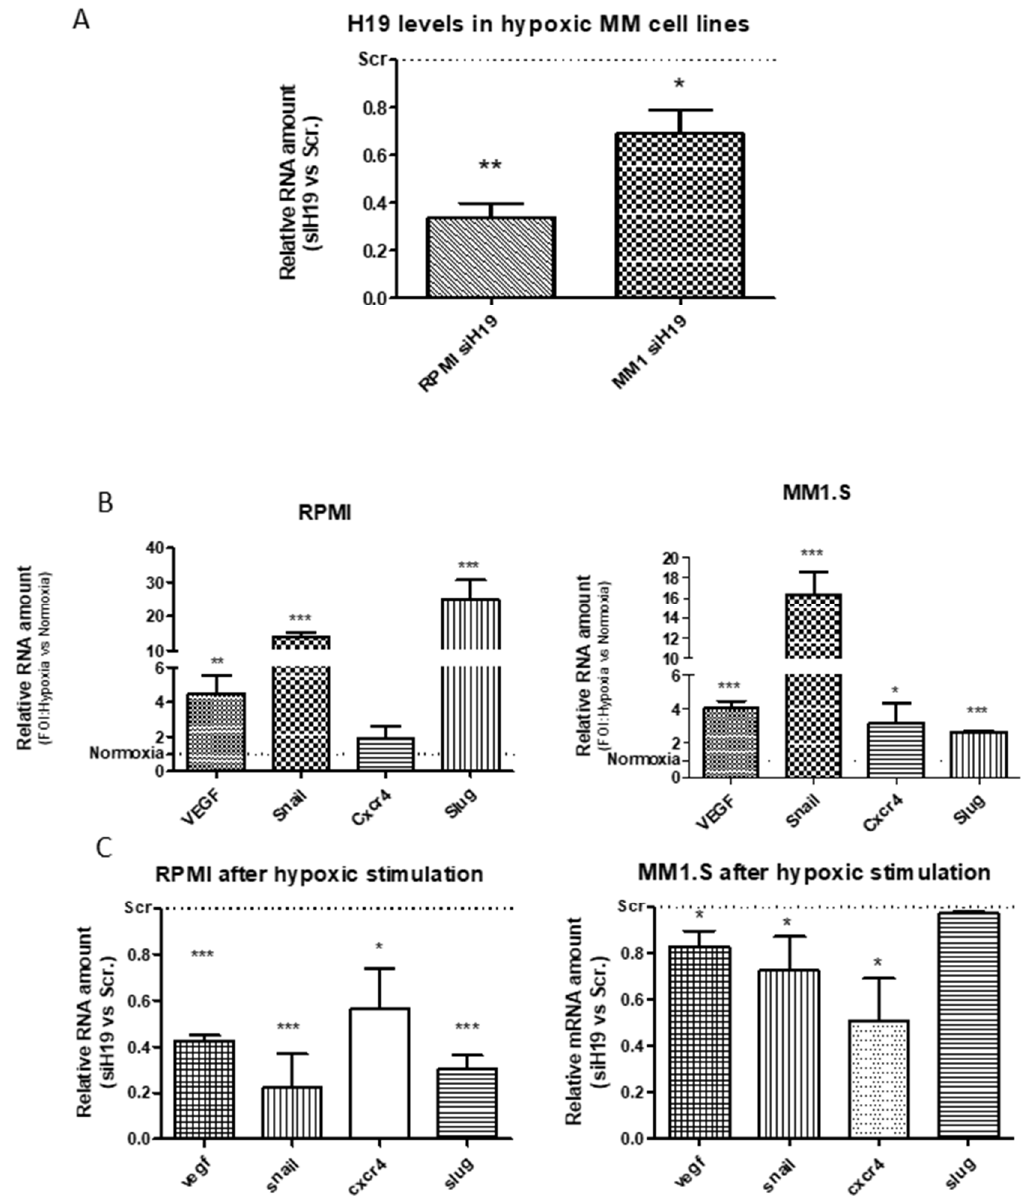
Figure 2. qRT-PCR indicate the H19 expression levels after hypoxic stimulation in MM cell lines infected with siH19 and relative controls. Value are expressed as Fold Of Increase (FOI) respect to siRNA Scramble (siScr) infected cells ( A ). qRT-PCR of indicated genes in MM cell lines after hypoxic stimulation compared to normoxia. Value are expressed as FOI respect to normoxic cells ( B ). qRT-PCR of indicated genes in hypoxic MM cell lines silenced or not for lncH19. Value are expressed as FOI respect to siScr infected cells ( C ). Values are presented as mean ± SD. Statistical analysis was performed by the use of Student t -test. * p < 0.05; ** p < 0.001; *** p <